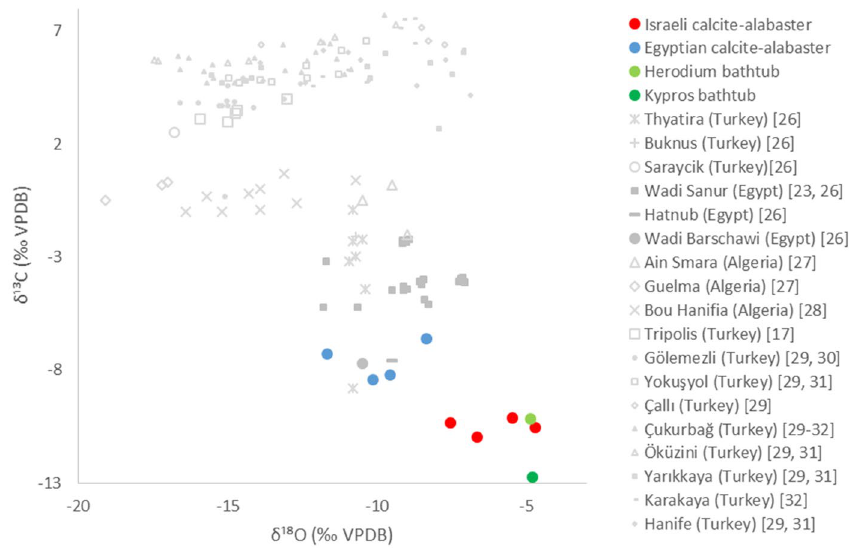
Figure 5. The δ 13 C and δ 18 O stable isotopes diagram. Distribution of the Israeli (red) and Egyptian (blue) samples of the present study, and literature data from the Mediterranean Basin (gray). Herod’s bathtubs data are in green. The numbers in parentheses refer to the reference from which the data was